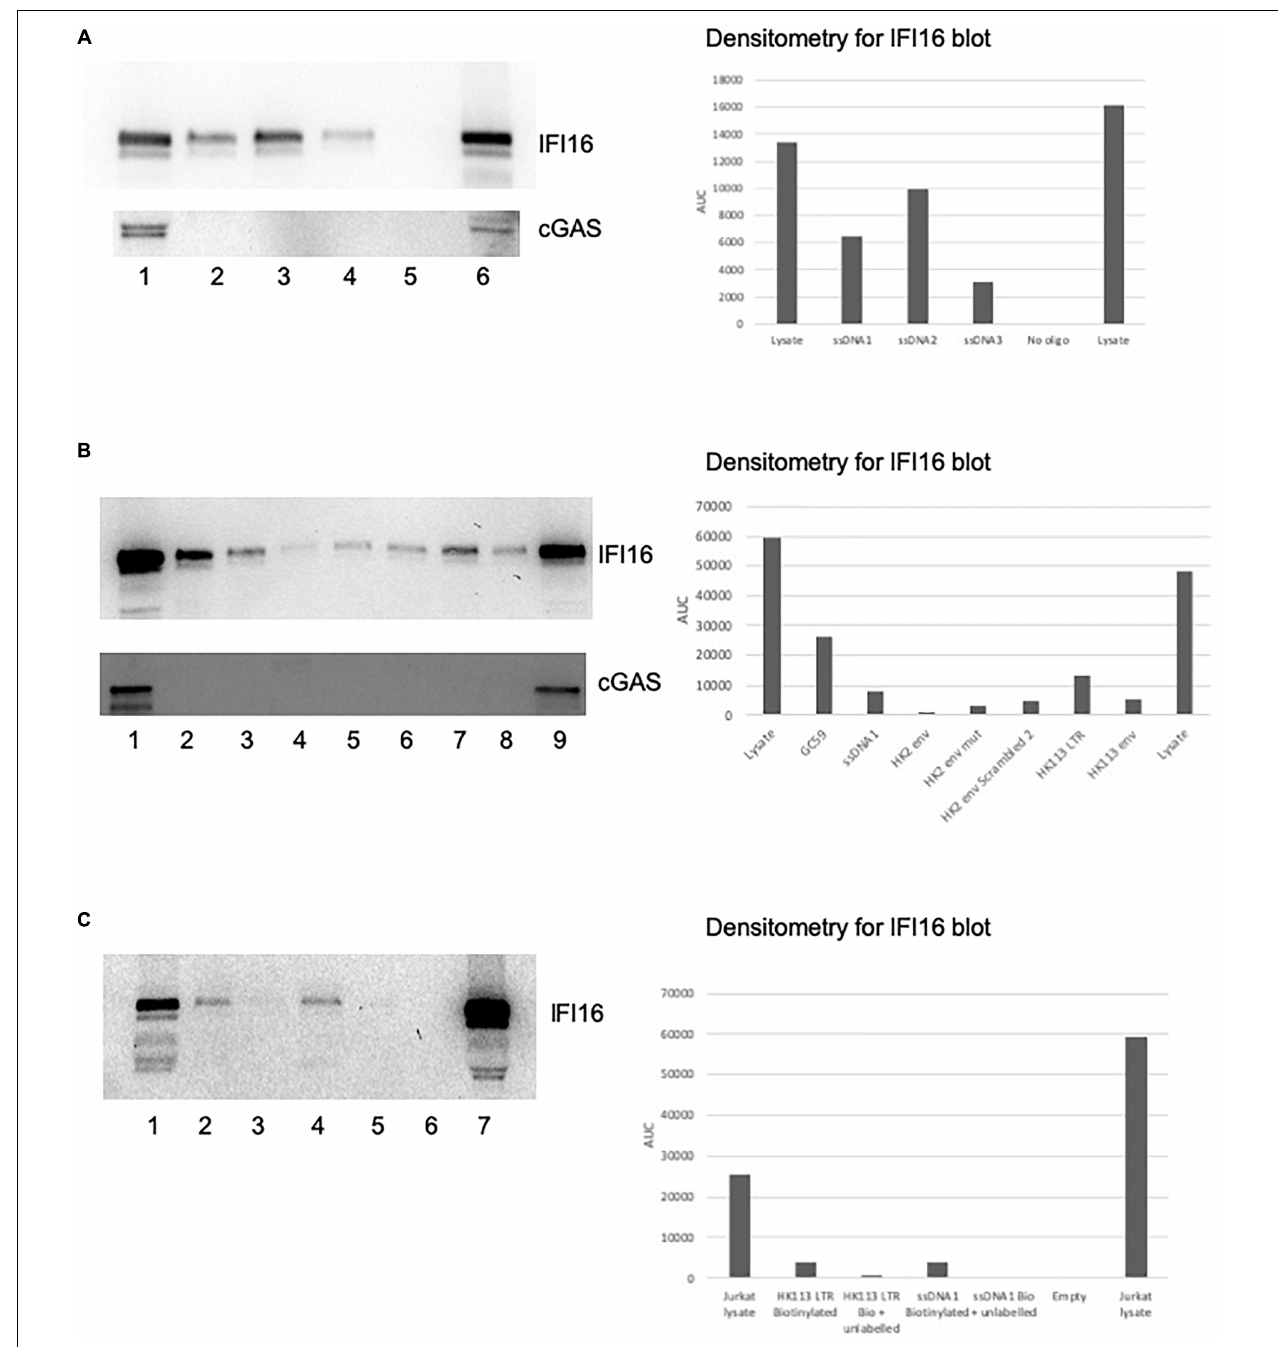
FIGURE 2 | IFI16 binds to oligos from HIV-1 and HERV-K. Pre-cleared Jurkat cell lysates were incubated with biotin-labeled oligos, as described in the section “Materials and Methods.” The pulldowns were analyzed by SDS-PAGE and western blotting first for IFI16, followed by reprobing the same blot for cGAS. (A) The ssDNA 1, 2 and 3 oligos (Jakobsen et al., 2013) were examined for their interaction with IFI16 (top panel) and cGAS (bottom panel). The lanes were loaded with input lysate or pulldowns with oligos as indicated: (1) input lysate, (2) ssDNA1, (3) ssDNA2, (4) ssDNA3, (5) no oligo control and (6) repeat of the input lysate. (B) A HK2 oligo from the consensus sequence, as well as the HK113 sequence, were analyzed for interaction with IFI16 (top panel) and cGAS (bottom panel). The lanes were loaded with input lysate or pulldowns with oligos as indicated: (1) input lysate, (2) GC59, (3) ssDNA1, (4) HK2 env , (5) HK2 env mut, (6) HK2 env scrambled 2, (7) HK113 LTR, (8) HK113 env and (9) a positive input lysate from a previous experiment as a blotting control. (C) In this competition assay, the biotinylated ssDNA1 and HK113 LTR oligos were used in pulldowns with and without an untagged version of the same oligo. The lanes were loaded as follows: (1) input lysate, (2) HK113 LTR biotinylated oligo only, (3) HK113 LTR biotinylated and unlabeled oligos, (4) ssDNA1 biotinylated oligo only, (5) ssDNA1 biotinylated and unlabeled oligos, (6) empty lane and (7) repeat of the input lysate. Densitometry was performed on the IFI16 blots by measuring the area under the curve (AUC) with Image J.